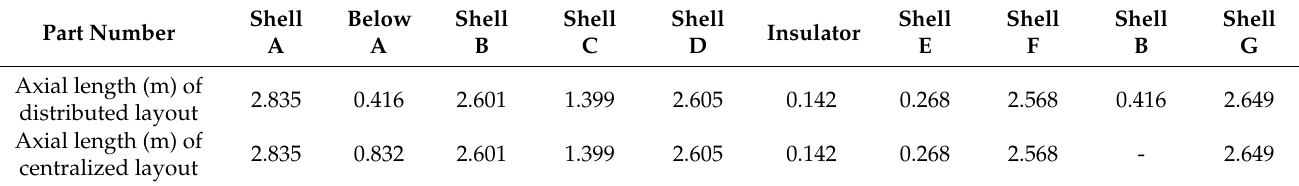
Table 1. Axial length of case object